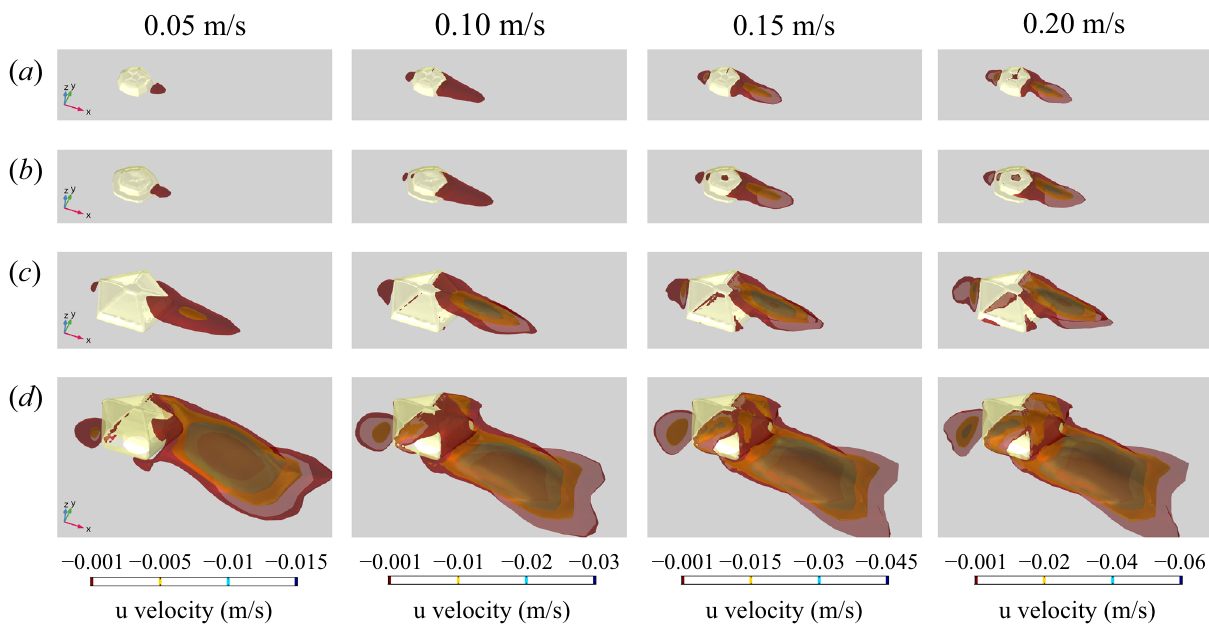
Figure 3. Three-dimensional isosurface plots of negative values of velocity component u (parallel to the x-axis) at three different inlet velocities (0.05–0.20 m/s). ( a ) Arkarua morphotype 1. ( b ) Arkarua morphotype 2. ( c ) Cambraster . ( d ) Stromatocystites . Direction of ambient flow from top left to bottom